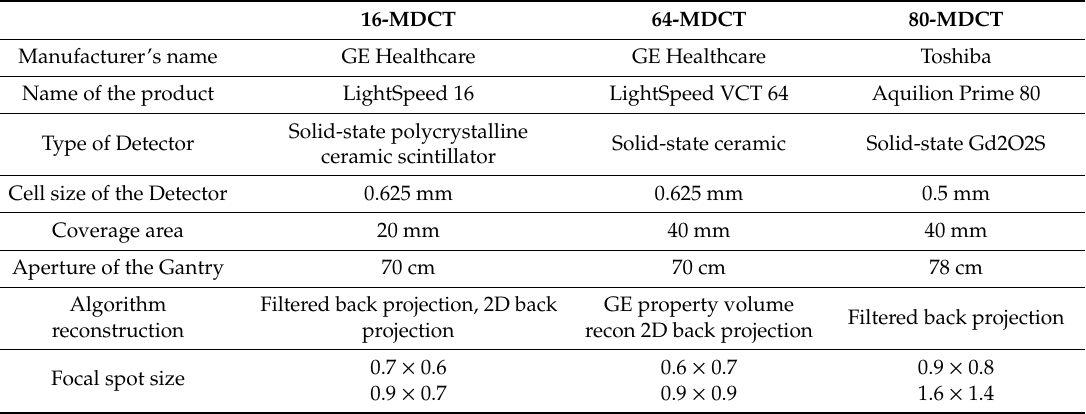
Table 1. Specifications of the CT Scanner.